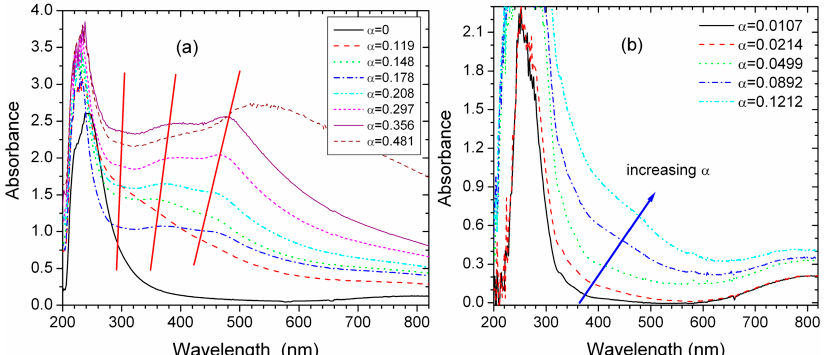
Figure 8. ( a ) UV-visible absorption spectra of the stoichiometric reduction of Cu(II) cations as a function of the relative amount, α , of reducing agent. The vertical lines show the evolution of the bands with the addition of the reducing agent. ( b ) UV-visible absorption spectra at small α values, with α ≤ 0.20. (from reference [